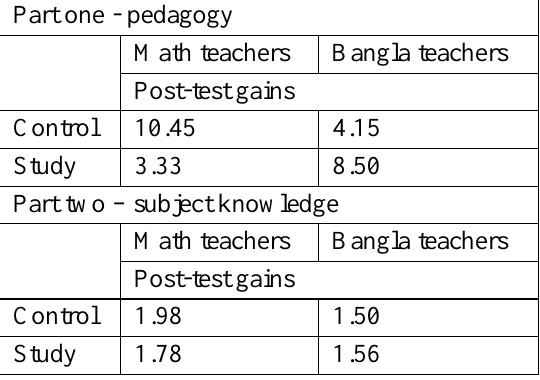
Post-Test Gains by Group (Adapted from Pouezevara & Khan, 2007a, p. 31) Part one -